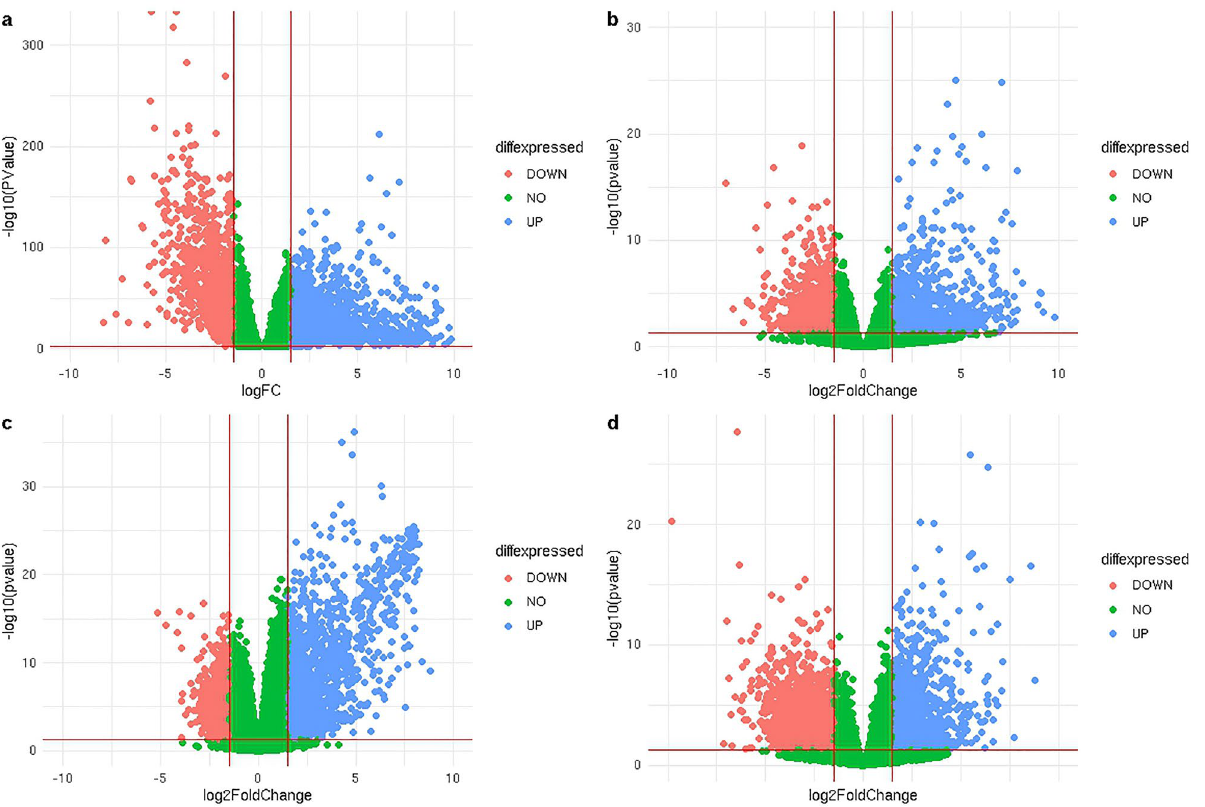
Figure 2. The volcano plot for distribution of DEGs in all CRC datasets. ( a ) TCGA-CRC, ( b ) GSE144259, ( c ) GSE50760, and ( d ) GSE87096. Green—non-significant DEGs, Red—upregulated genes, and Blue— downregulated genes.